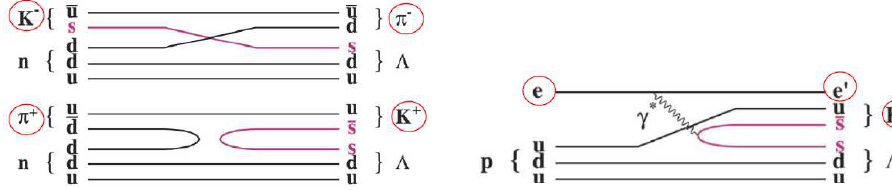
Figure 2. n ( K − , π − ) Λ and n ( π + , K + ) Λ reactions (left), and p ( e , e ′ K + ) Λ reaction